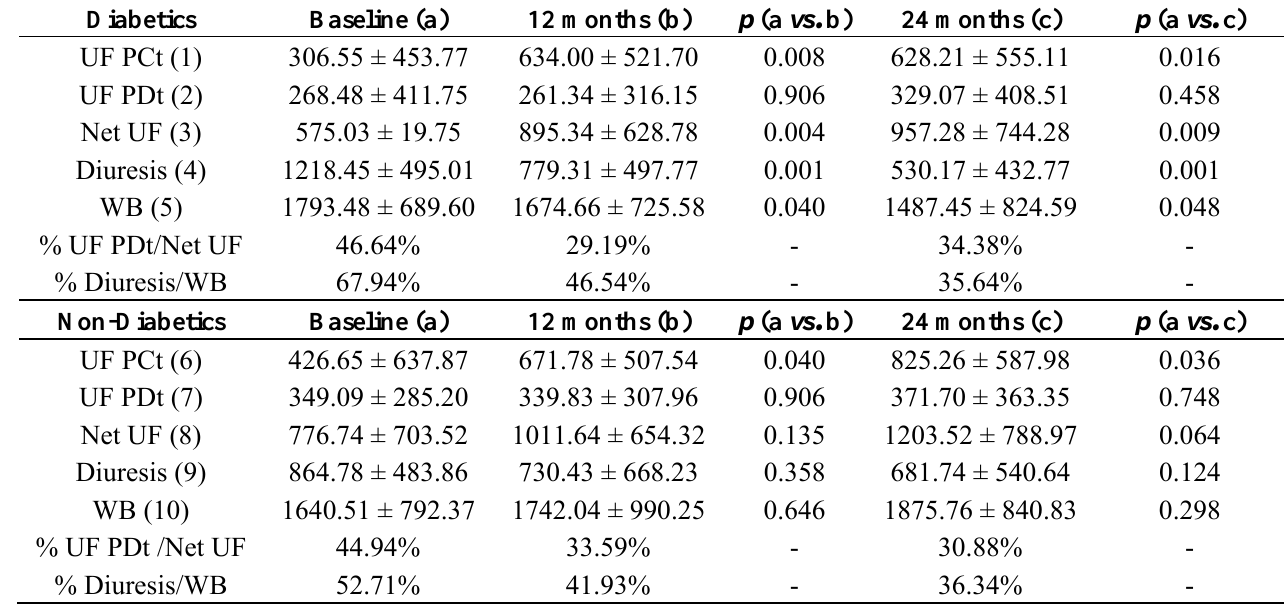
Table 6. Ultrafiltration (UF) and water balance (WB) (mL/day).